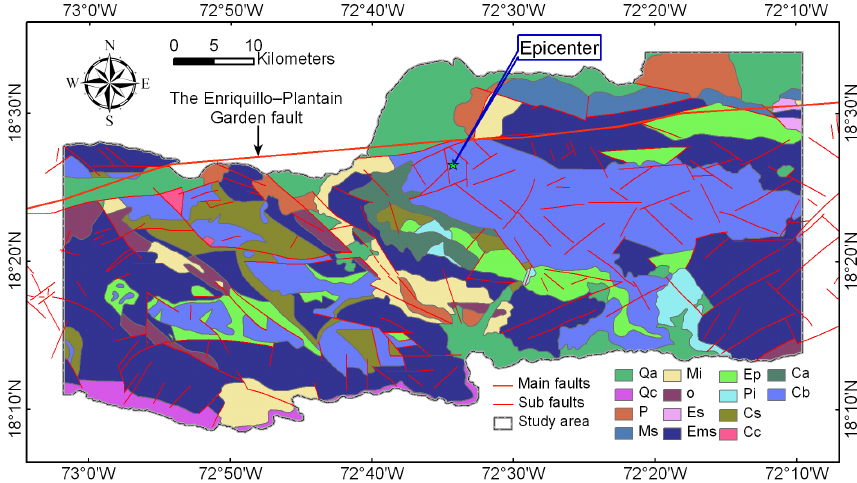
Figure 2. The bedrock distribution map of the study area.